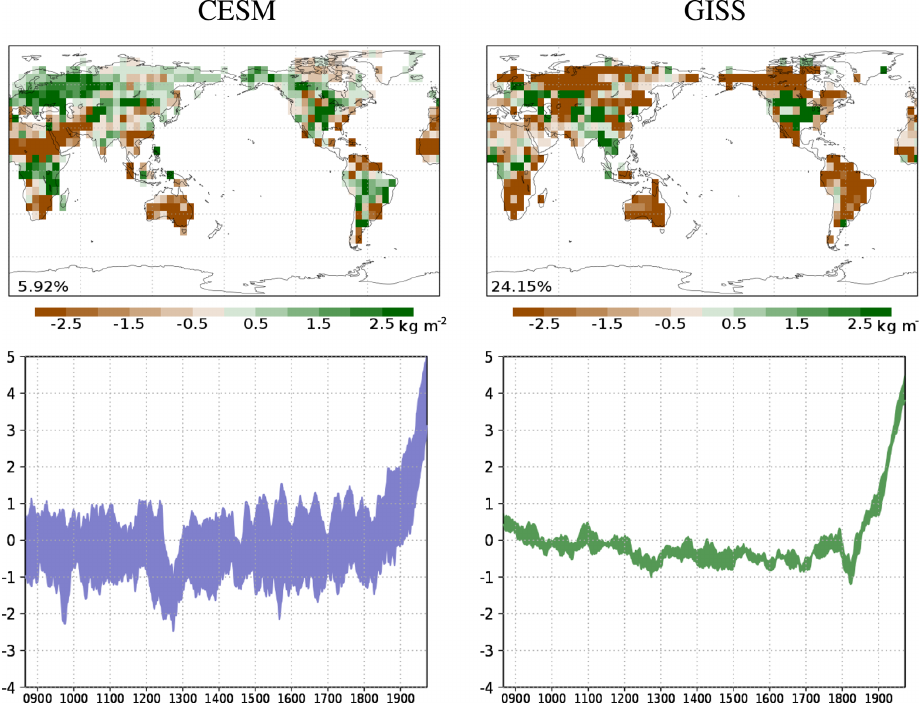
Figure 18. Second EOF and PC of soil moisture for the subensembles of CESM and GISS.